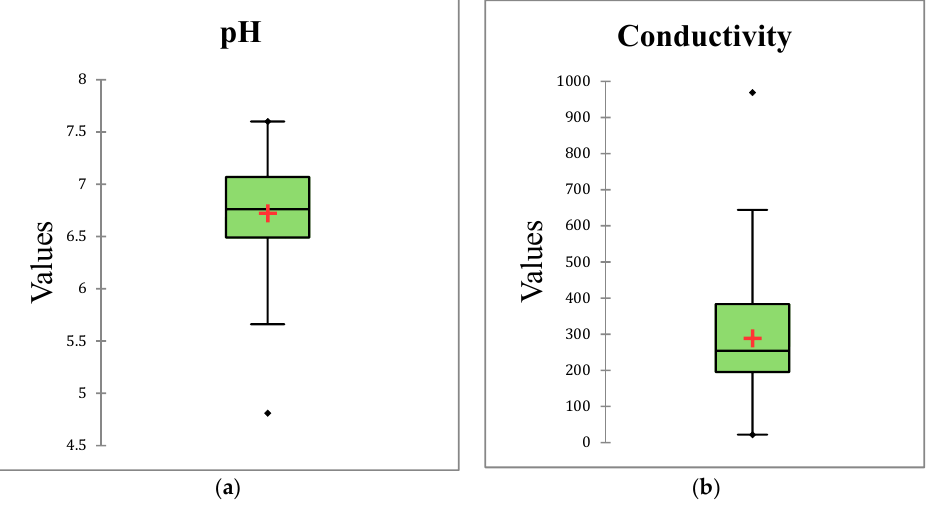
Figure 2. ( a ) pH variation.( b ) Conductivity variation.